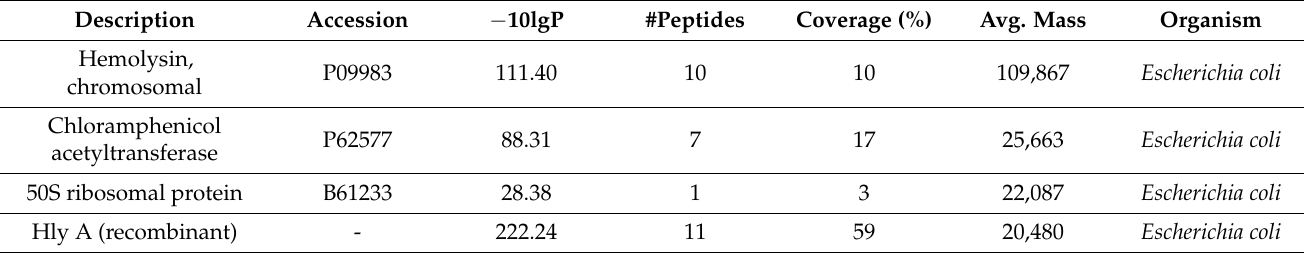
Table 3. Proteins identified by mass spectrometry.